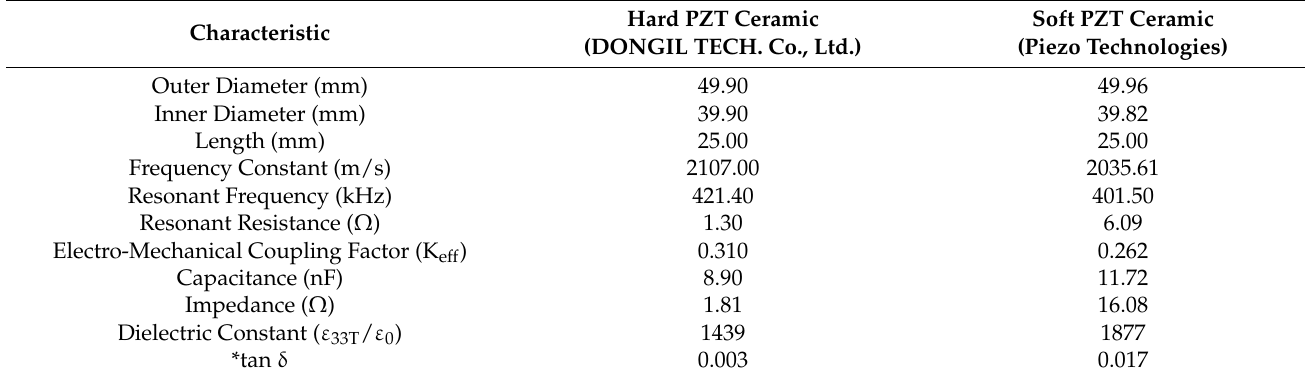
Table 1. Specifications of ring-shaped lead zirconate titanate (PZT) transducers.